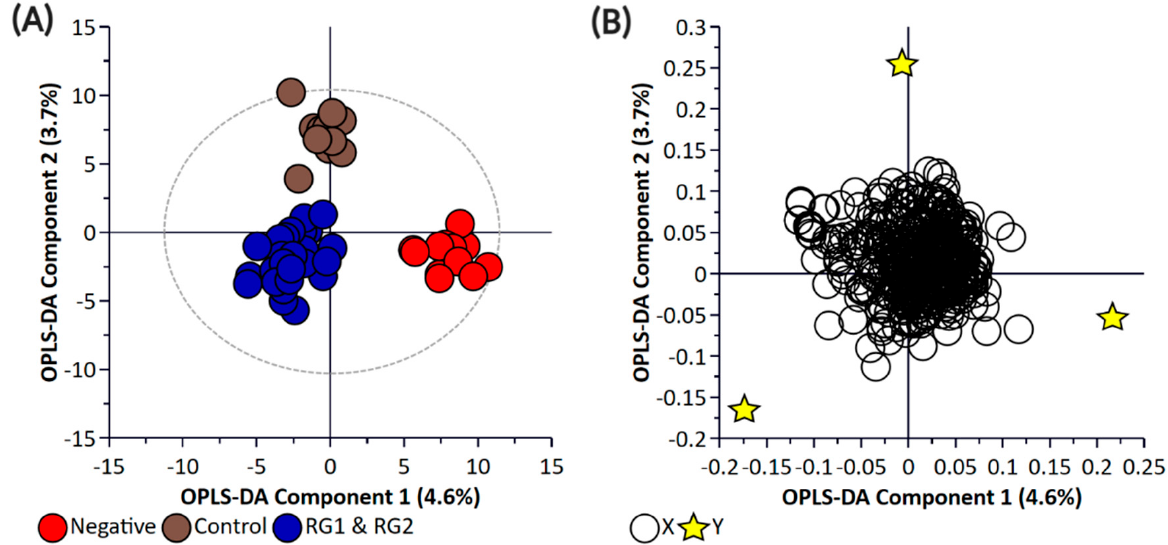
Figure 7. Orthogonal Partial Least Square-Discriminant Analysis ( A ) scatter plot and ( B ) loading plot of bacterial supernatant samples collected from inoculated spinach samples ( n = 58). R 2 X (cum) = 0.512, R 2 Y (cum) = 0.882, Q 2 = 0.481. Note, the ellipse presented in Figure 7A represents Hotelling’s confidence limit (95%). Note: The colored circles in panel “ A ” represent each analyzed sample, while the yellow-colored stars in panel “ B ” indicate the average group position for each sample cluster, with the white circles representing the distribution of metabolite features between these groups.